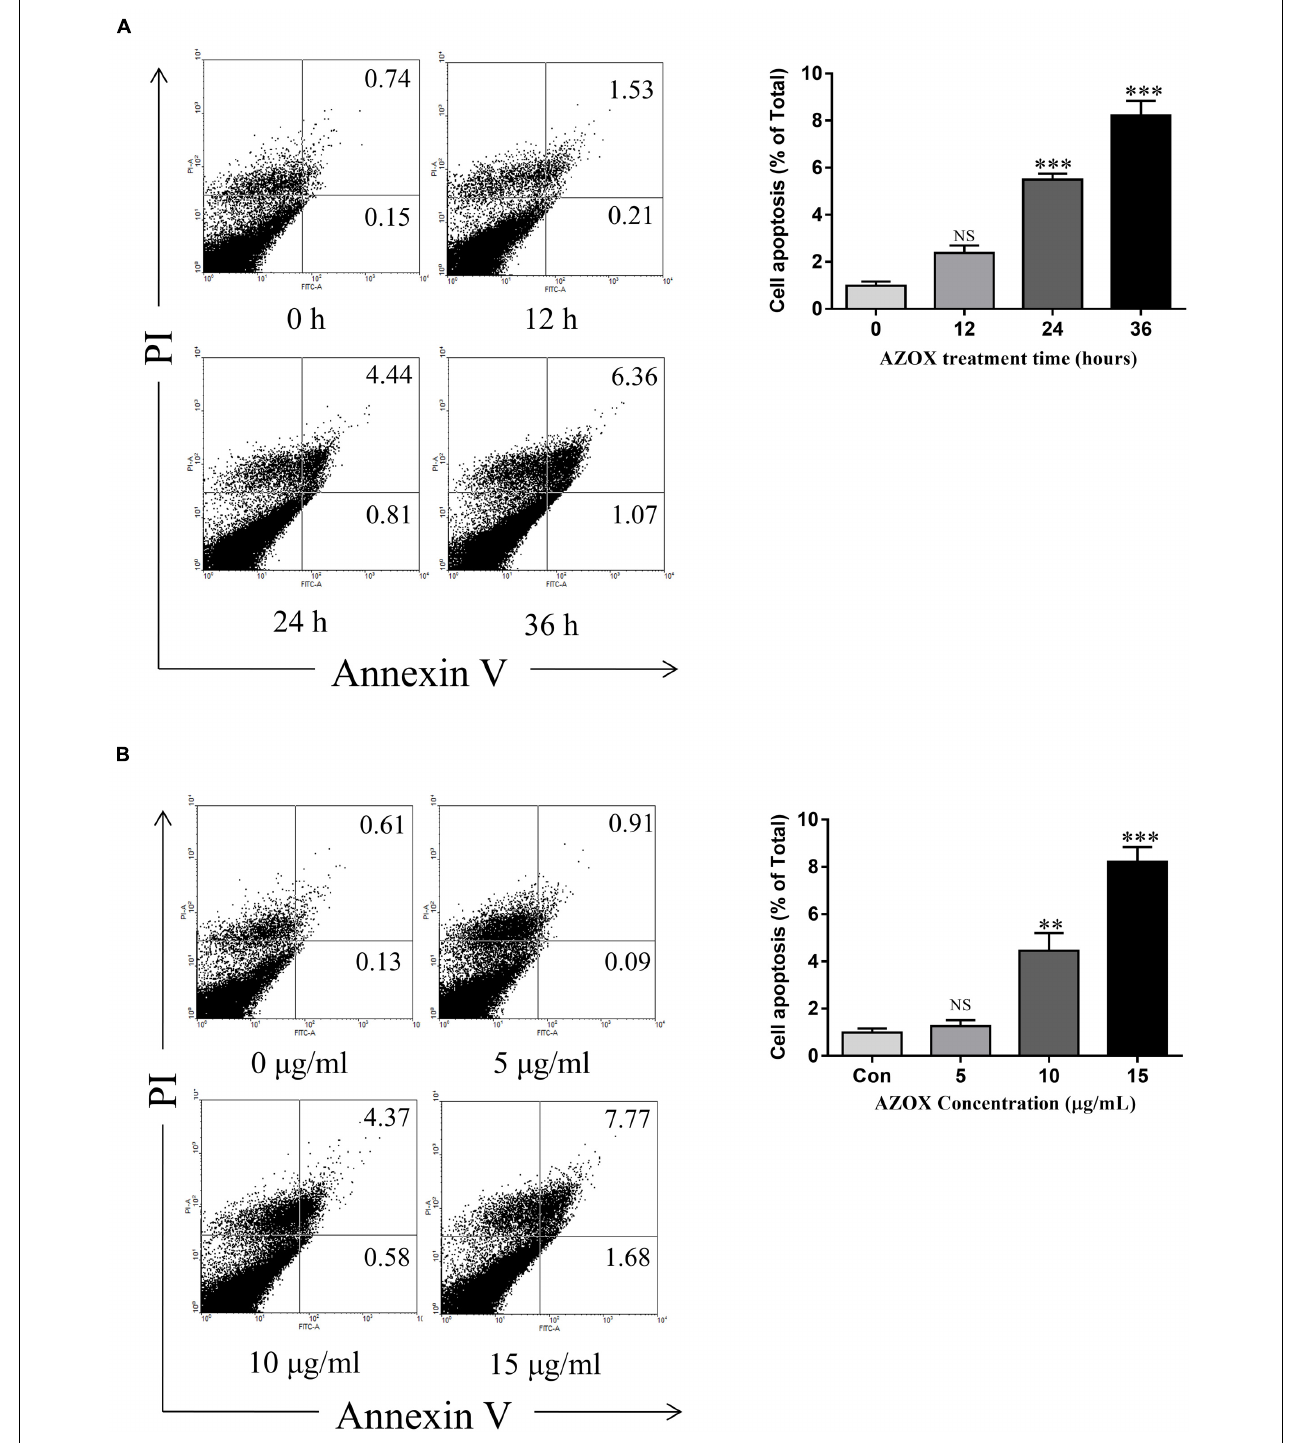
FIGURE 3 | AZOX induced KYSE-150 cell apoptosis. (A) Cells were treated with AZOX (15 µ g/ml) time-dependently. (B) Cells were treated with AZOX dose-dependently. Flow cytometry cell apoptosis analysis were then performed. Statistical charts of the apoptosis cells were illustrated. All data are represented as means ± SEM of three independent experiments (NS: not significant, ∗ p < 0.05, ∗∗ p < 0.01, and ∗∗∗ p < 0.001).